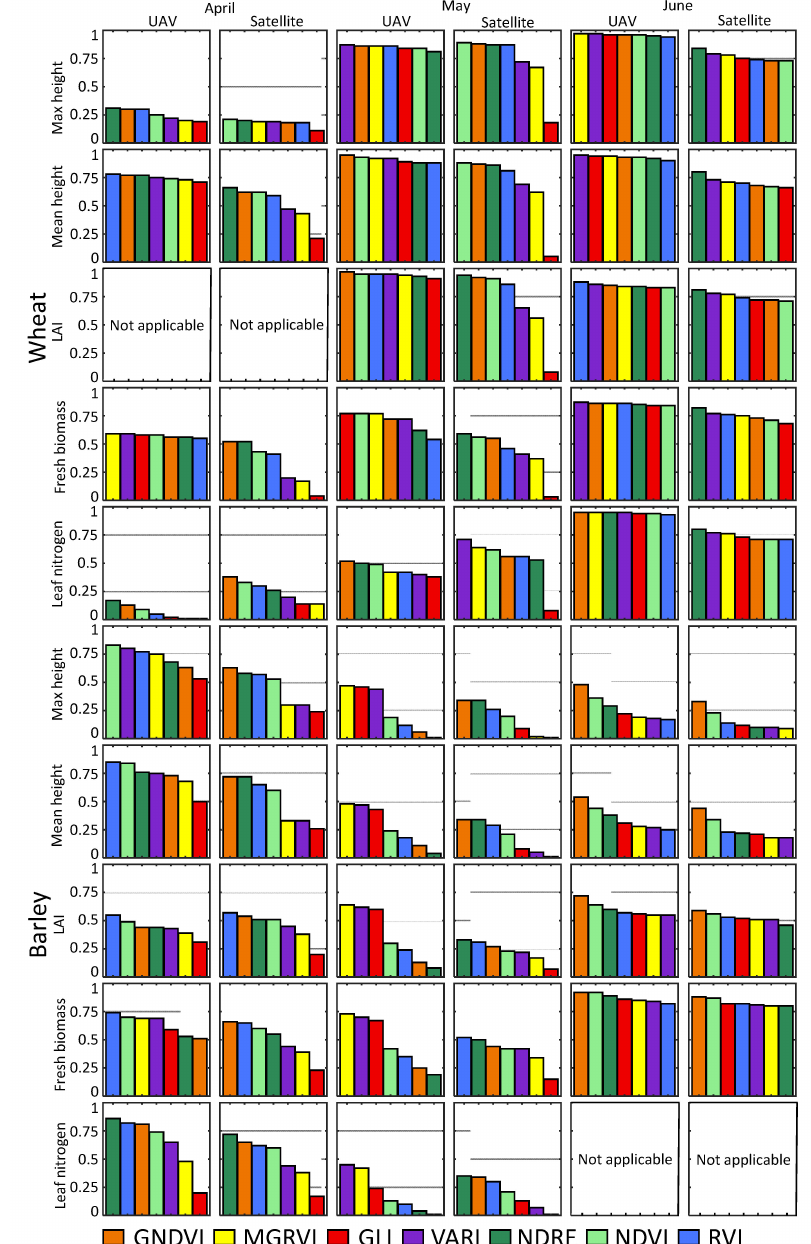
Figure 13. Bar plots showing the correlation coefficient magnitude (Pearson) between the agronomic parameter and the VI values categorized for crop type and